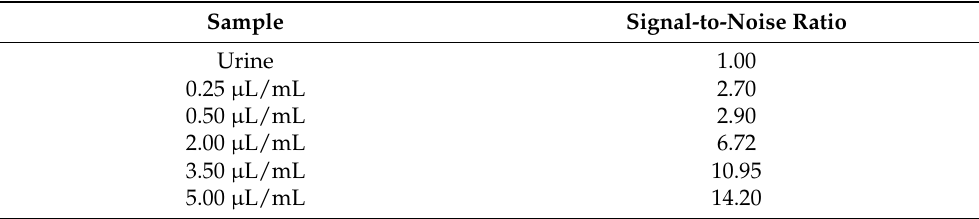
Table 2. The LoD of ethanol in human urine for the method of cuvette was determined based on the signal-to-noise